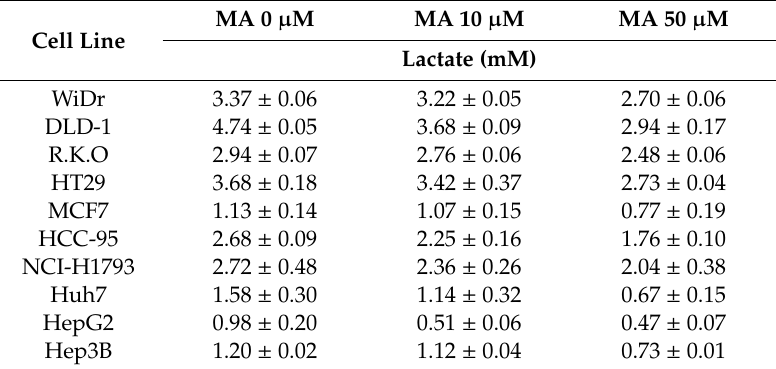
Table 2. Inhibitory e ff ect of M machilin A (MA) on the production of